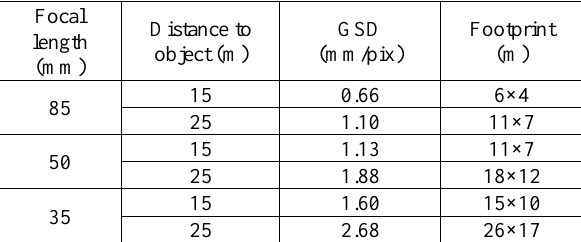
Table 1 . Parameters estimation based on three lenses of